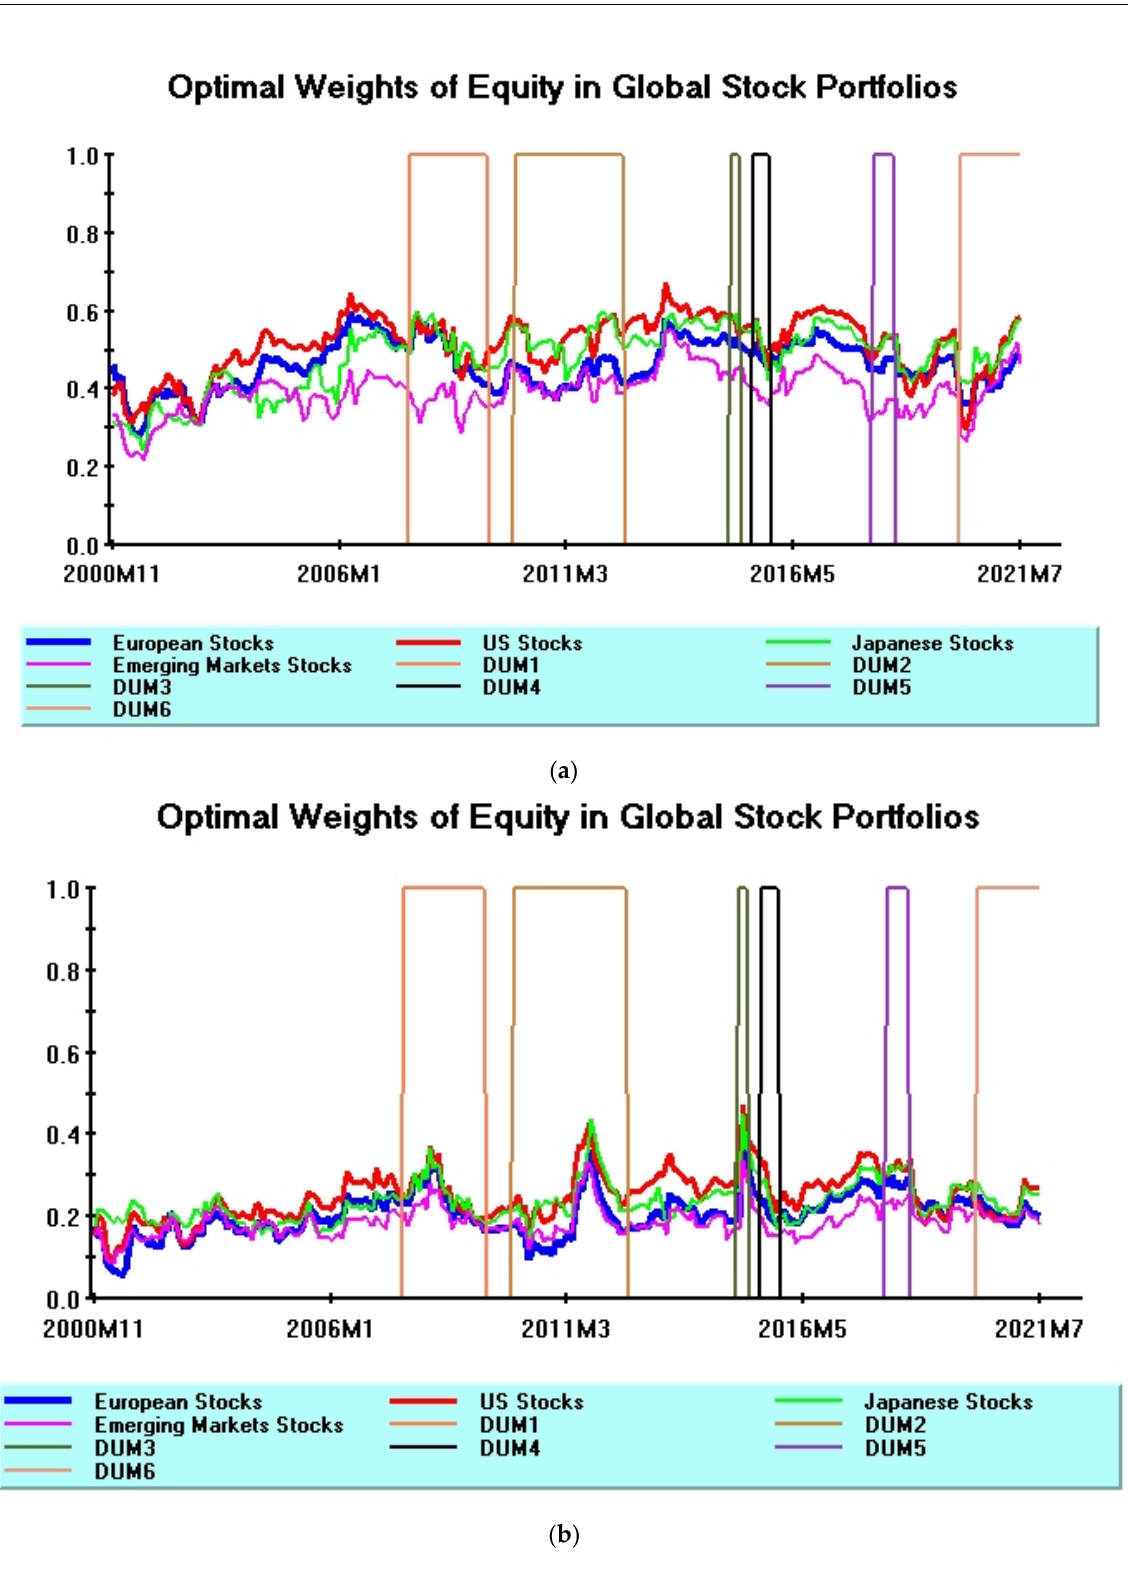
Figure 1. ( a ) Gold as a safe haven asset; ( b ) Swiss Franc as safe haven asset.